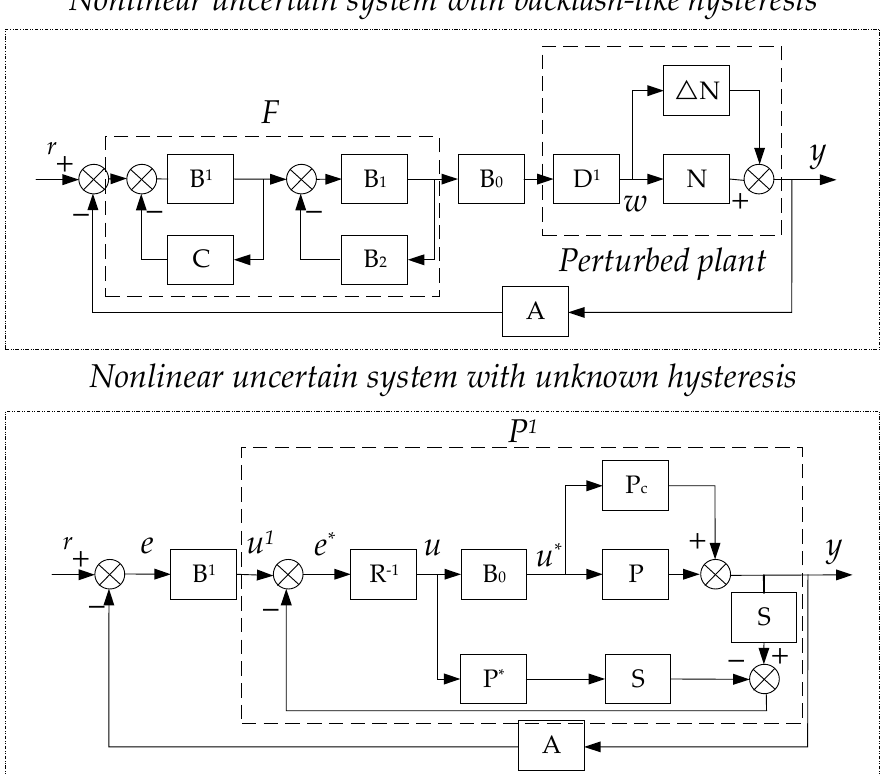
Figure 9. Controller for the nonlinear uncertain system with hysteresis.